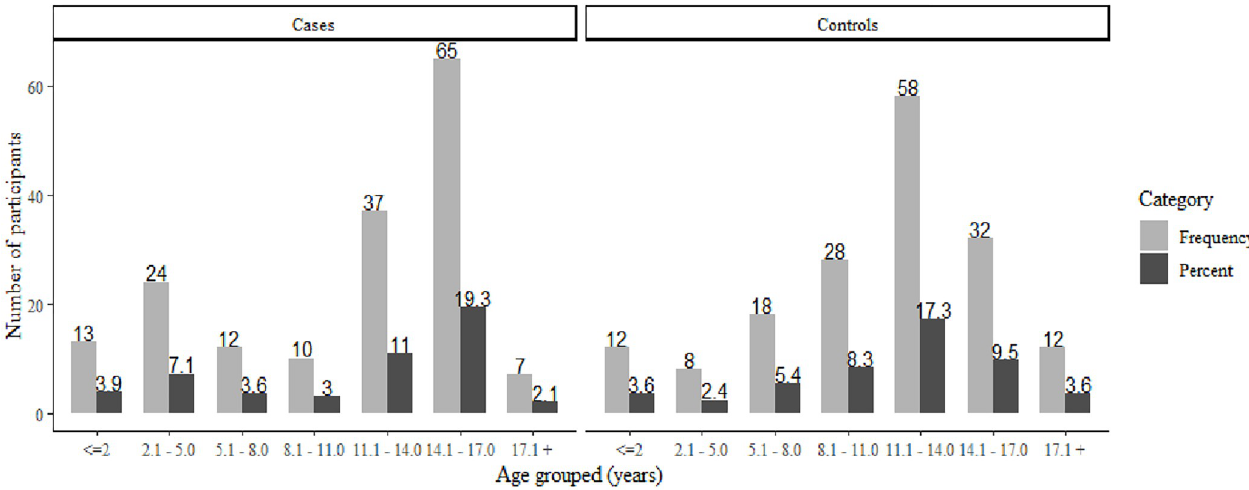
Fig 2. Age demographic distribution of the participants. Children from both groups of cases and controls of the brain atrophy are skewed more toward the right extreme of age with the peak age between 14.1–17.0 years.